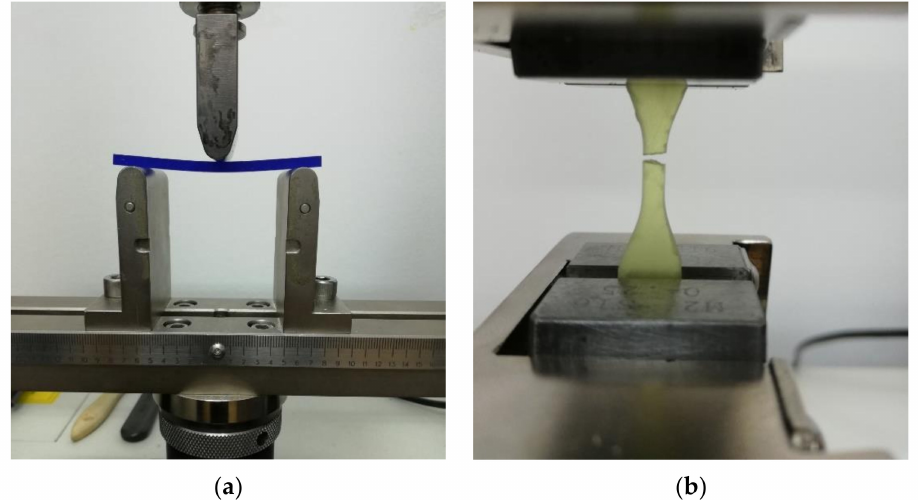
Figure 1. Specimens being tested to determine the mechanical characteristics of the investigated materials: ( a ) bending the specimen in a three-point bending test; ( b ) tensile specimen (Type V) after the tensile